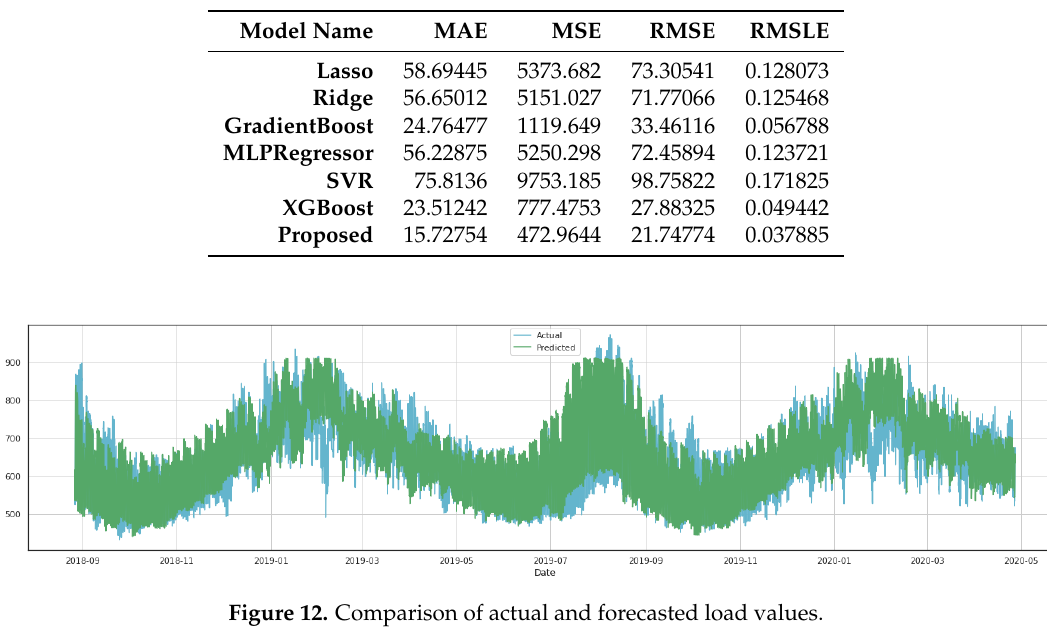
Table 2. Evaluation metrics.